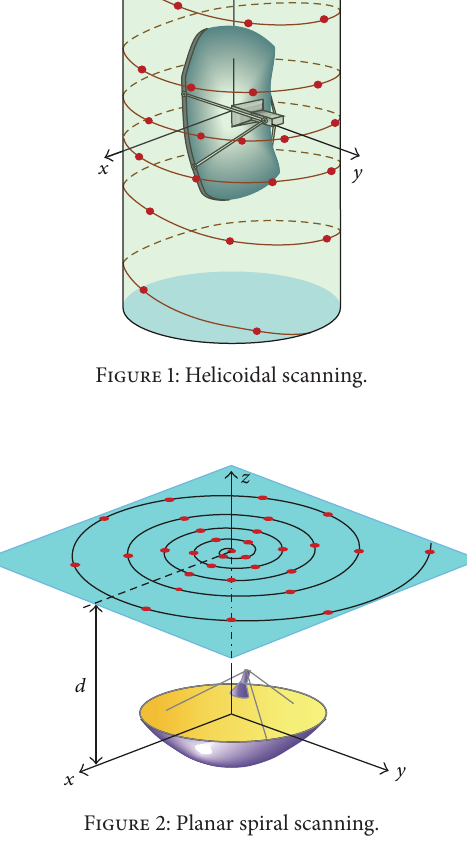
Figure 2: Planar spiral scanning.